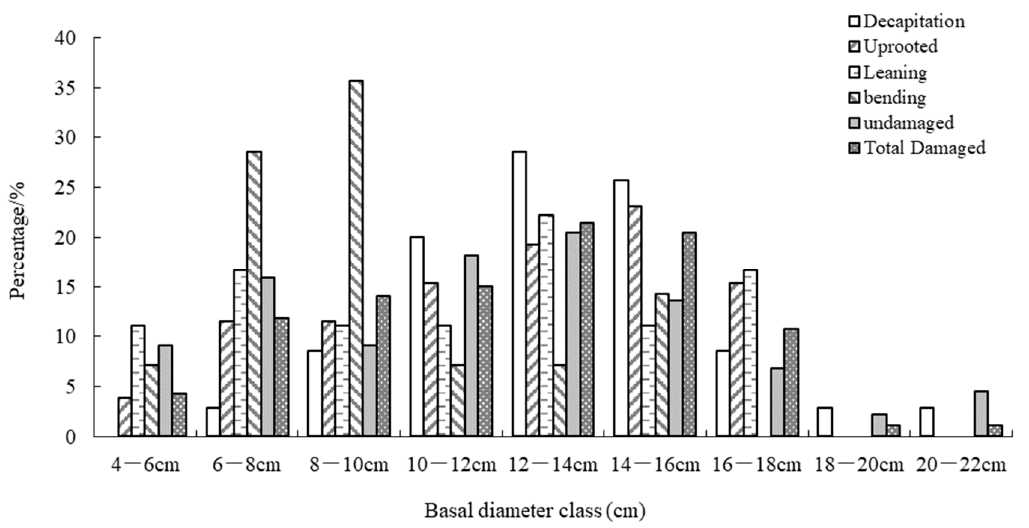
Figure 2. The distribution percentage of five damage types for S. superba total damaged trees in six sample plots following the 2008 ice storm.